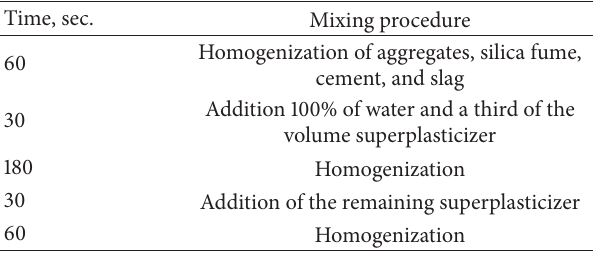
Table 4: Mixing procedure of HPC.